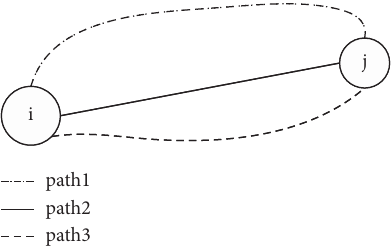
Figure 2: Schematic diagram of the